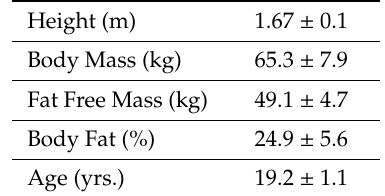
Table 1. Summary of subject demographics ( n =